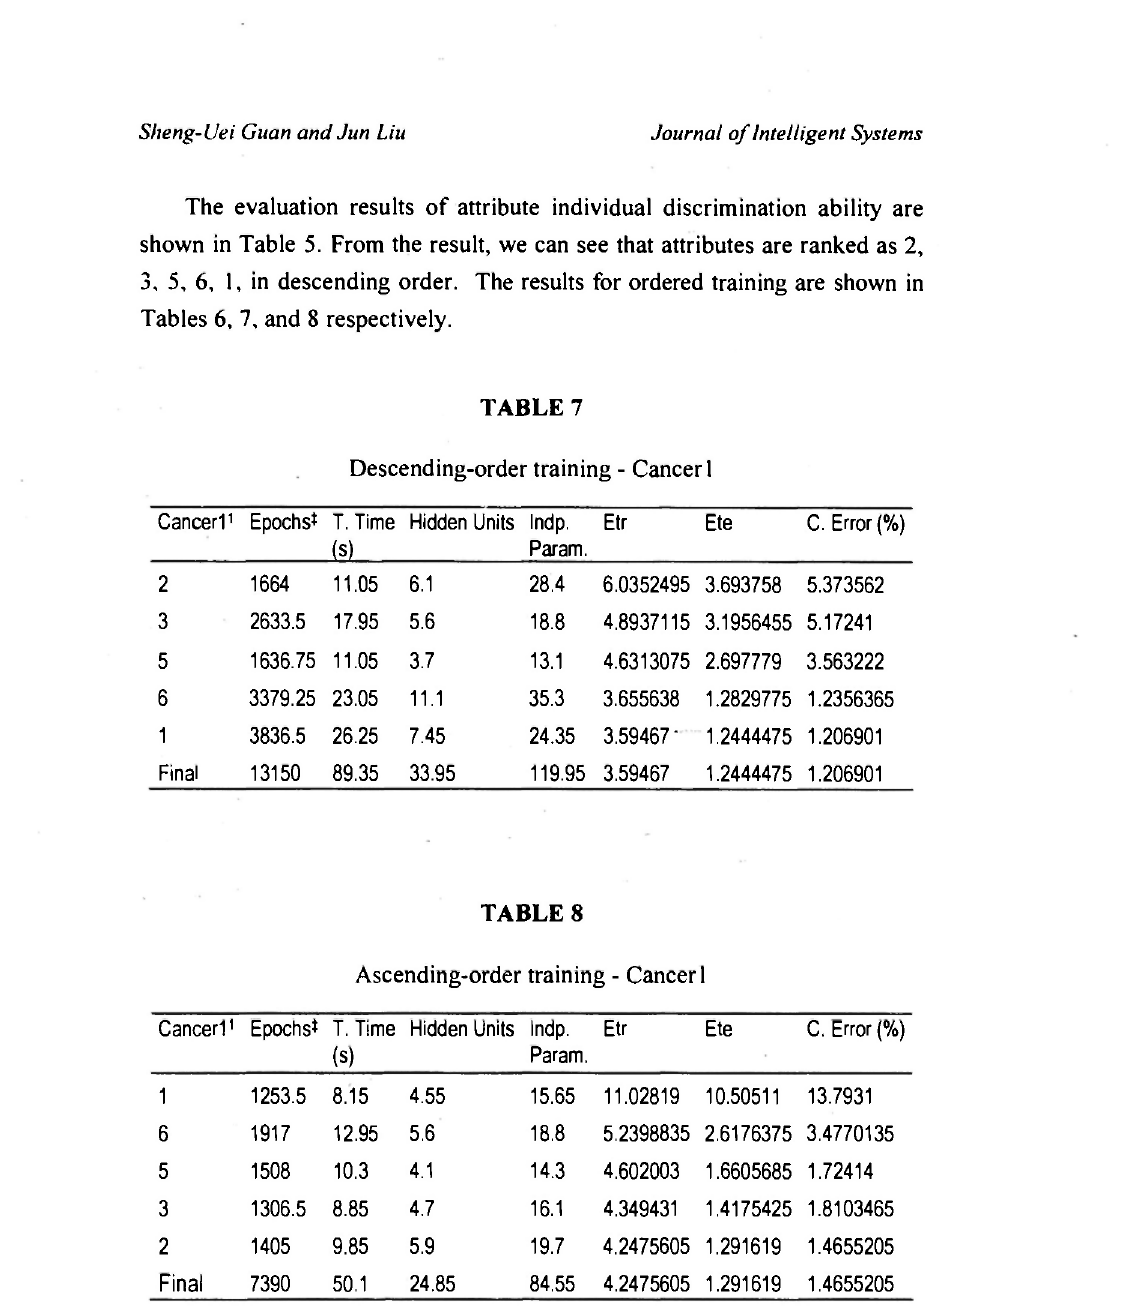
Ascending-order training -